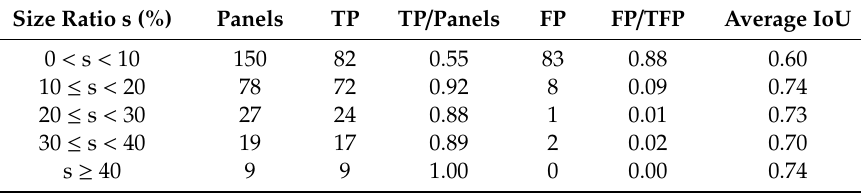
Table 6. Detection results for YOLOv3 network in relation with panel size ratios. Size Ratio s (%) Panels